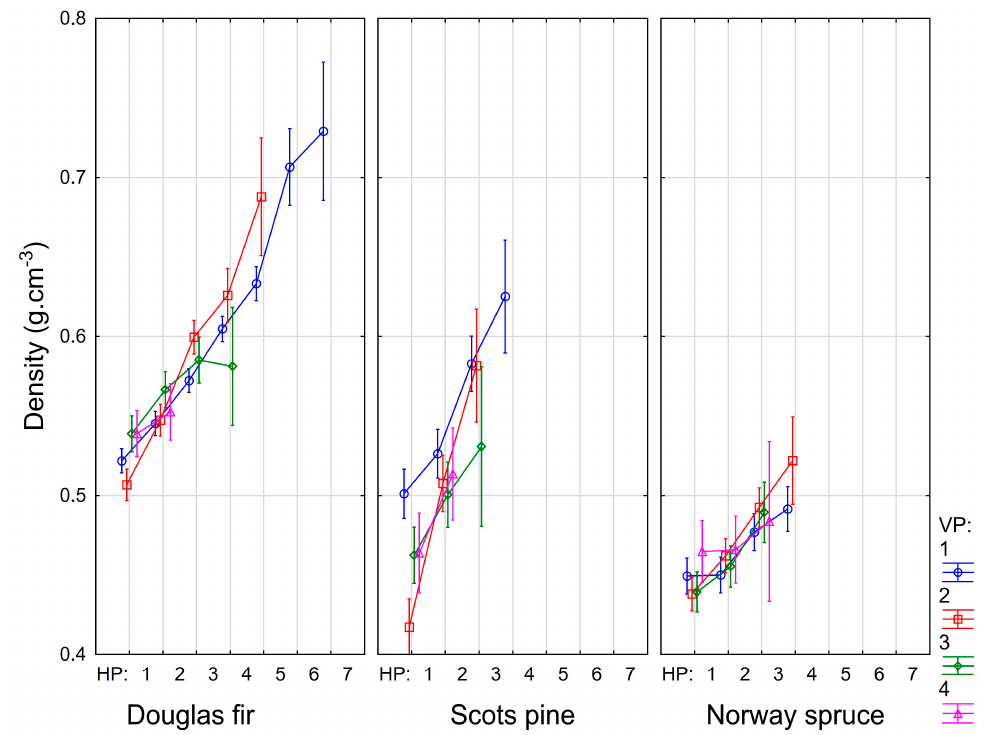
Figure 5. Within stem variability of wood density (HP—horizontal position, VP—vertical position).